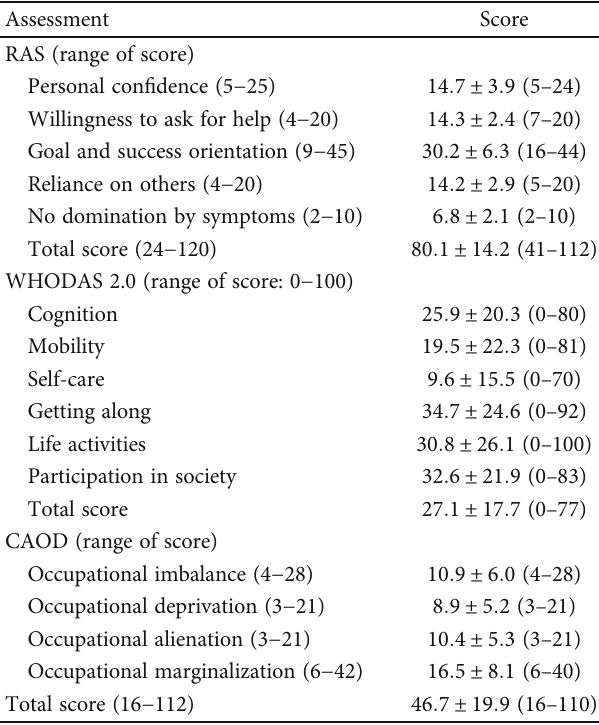
Table 2: Assessment